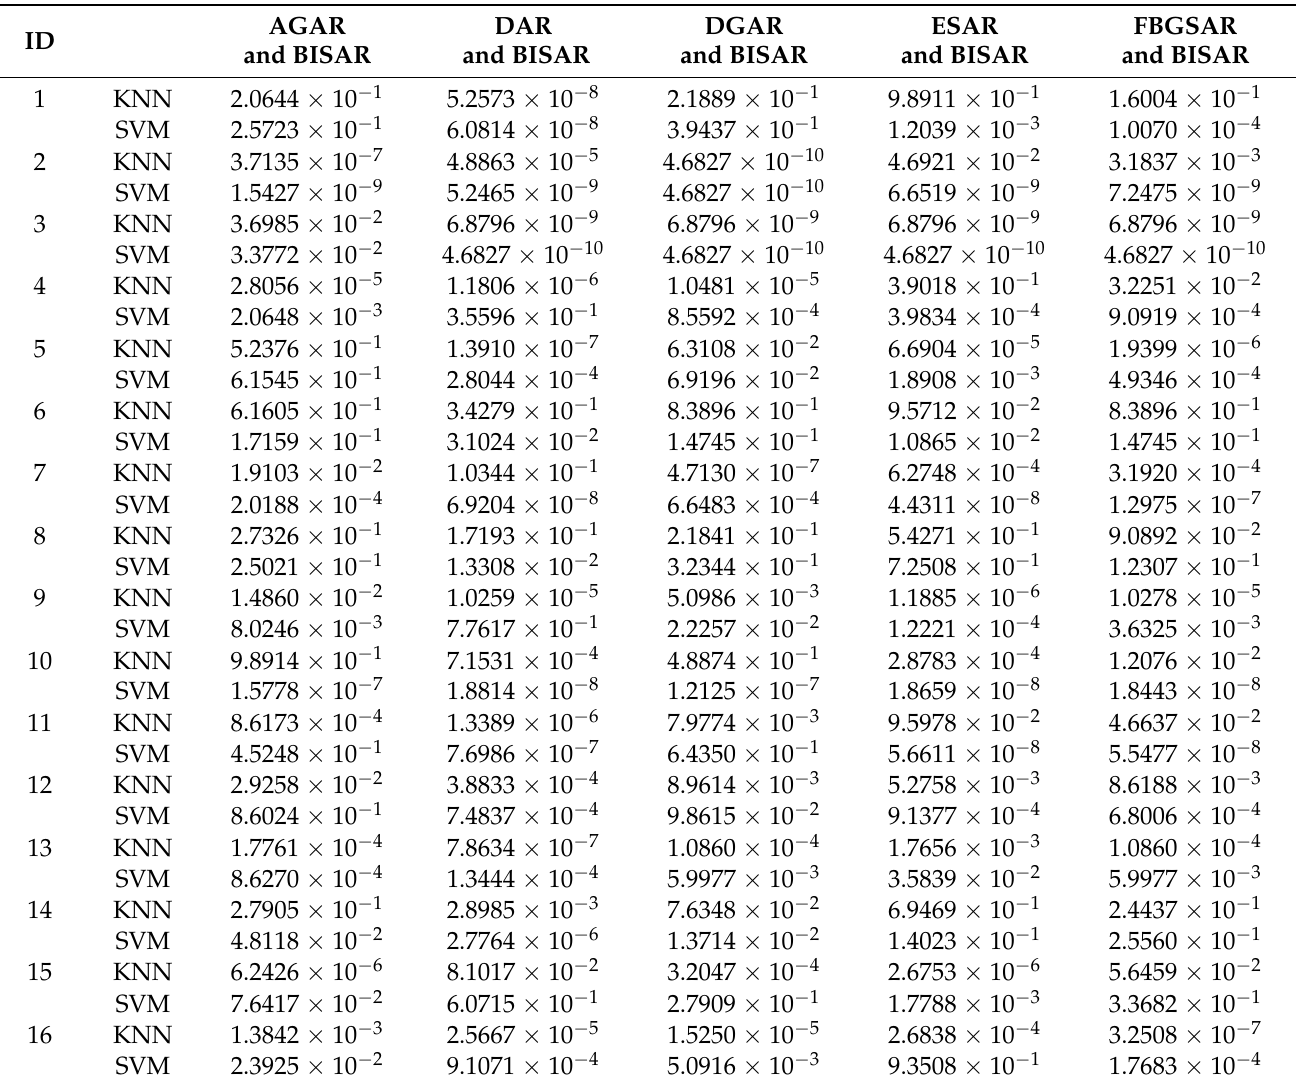
Table 14. p -values for comparing classification accuracies (raw data).